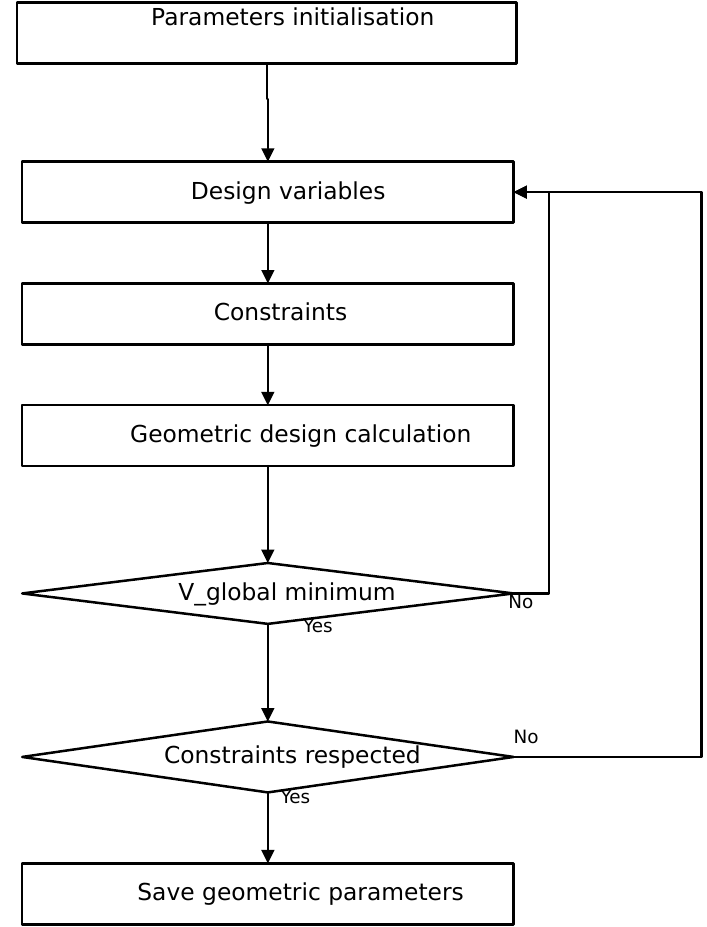
Figure 7. Algorithm